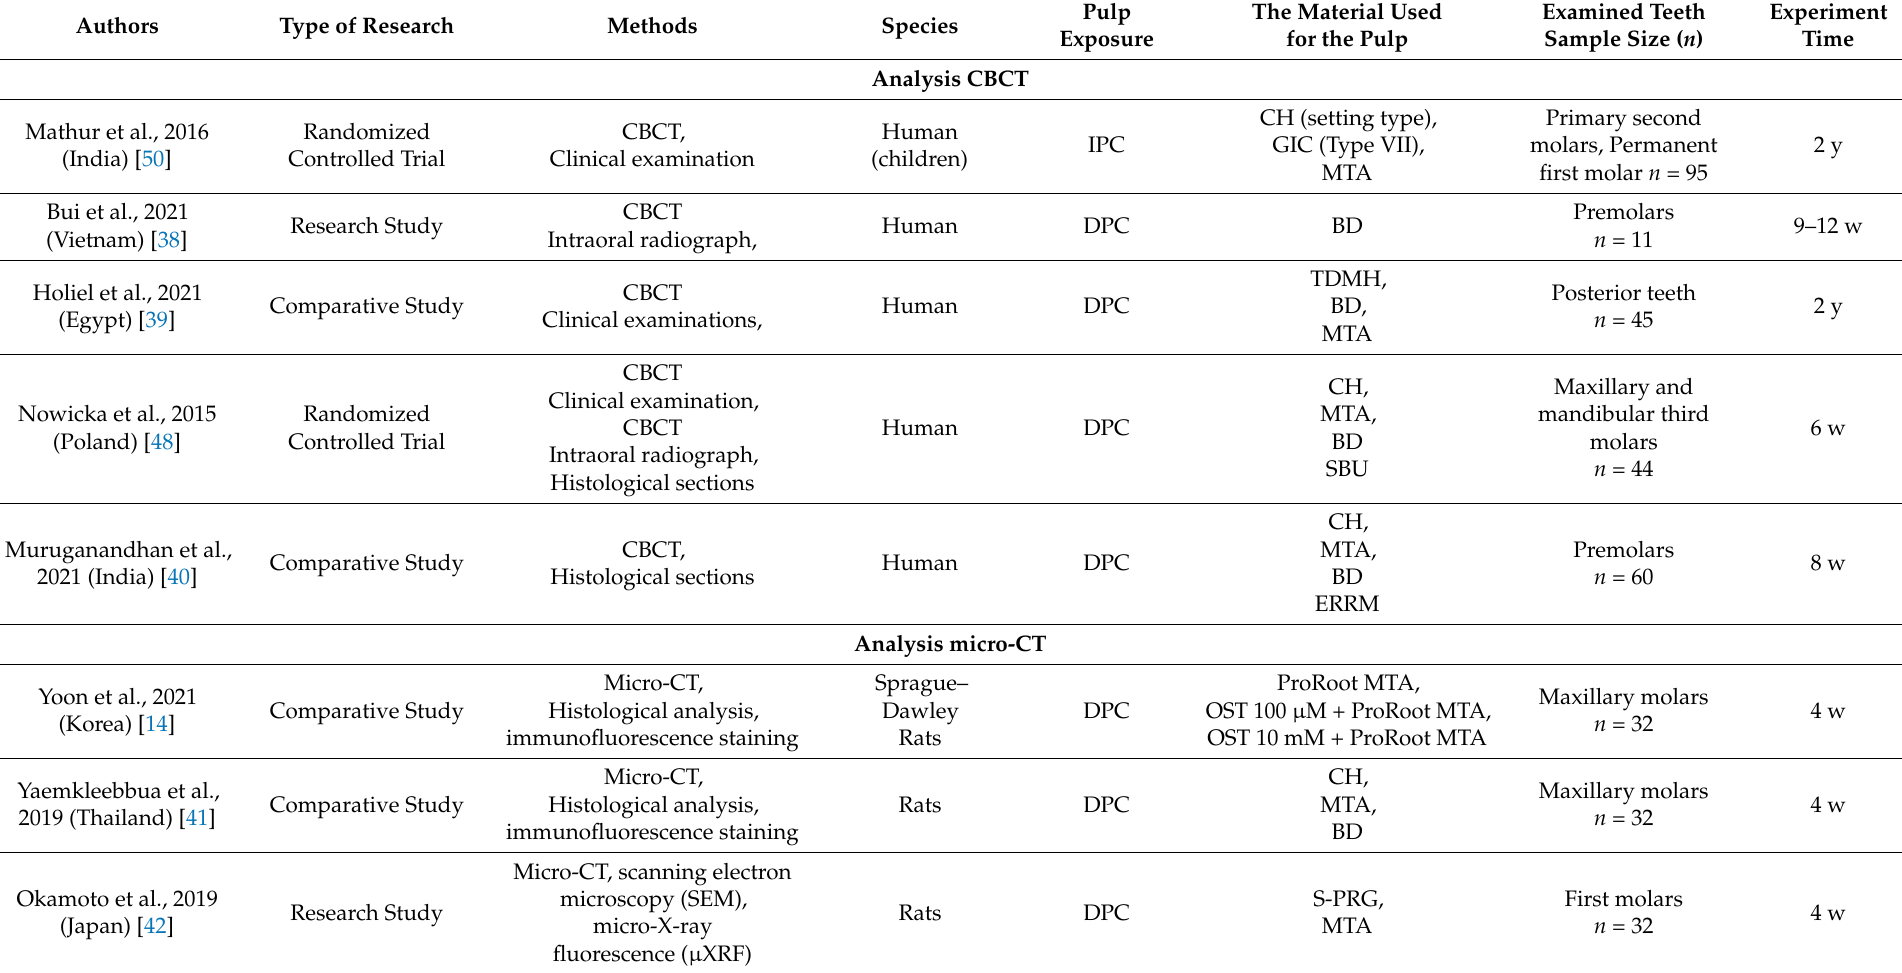
Table 6. Summary of the research studies on the CBCT, micro-CT and